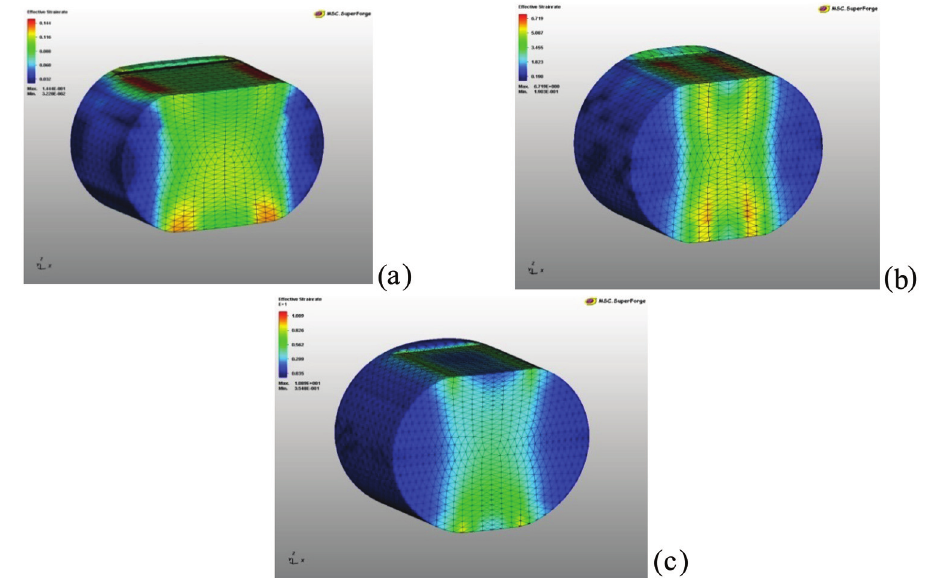
Figure 5: Picture of deformation intensity distribution in workpiece at a broach in flat baizes with single reduction of 80%, t ¼ 1,250°C. (a) S ¼ 1.0; (b) S ¼ 0.8; (c) S ¼